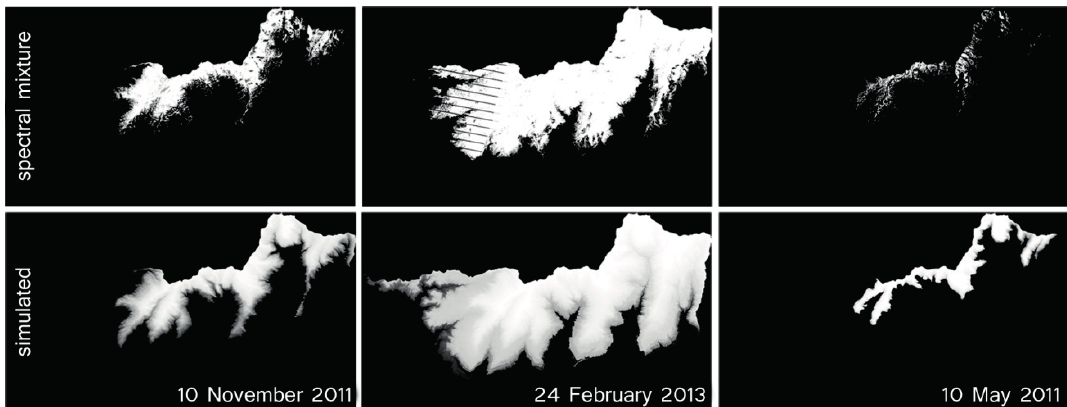
Fig. 4 Comparison between measured (up) and simulated (down) snow cover fraction maps for selected dates 10 November 2011 (RMSE = 0.261 m 2 m -2 ); 24 February 2013 (RMSE = 0.180 m 2 m -2 ) and 10 May 2011 (RMSE = 0.301 m 2 m -2